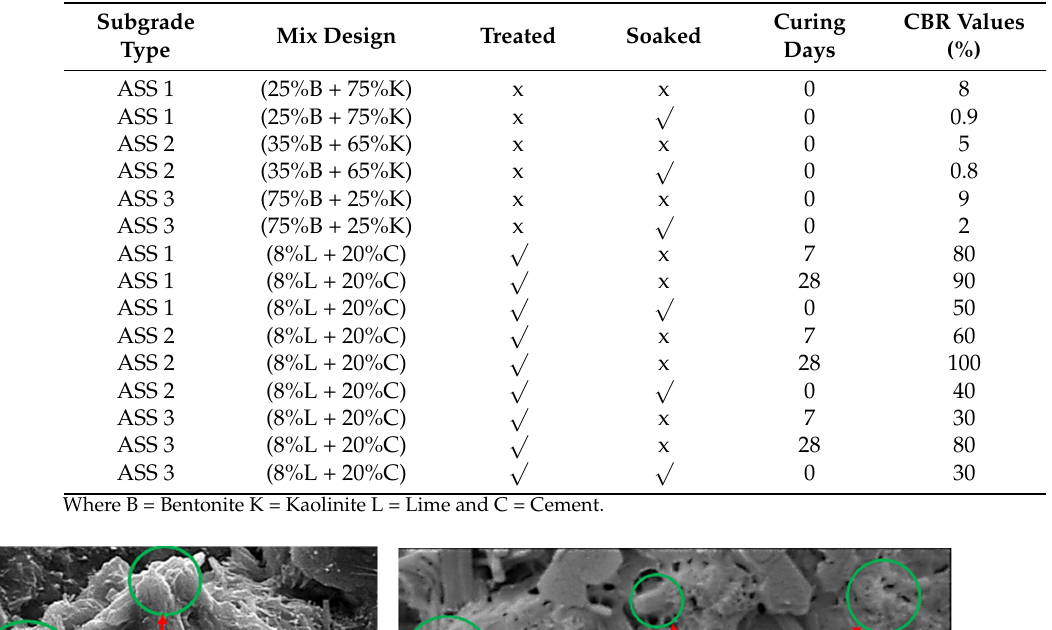
Table 2. CBR results for treated and untreated ASS materials.